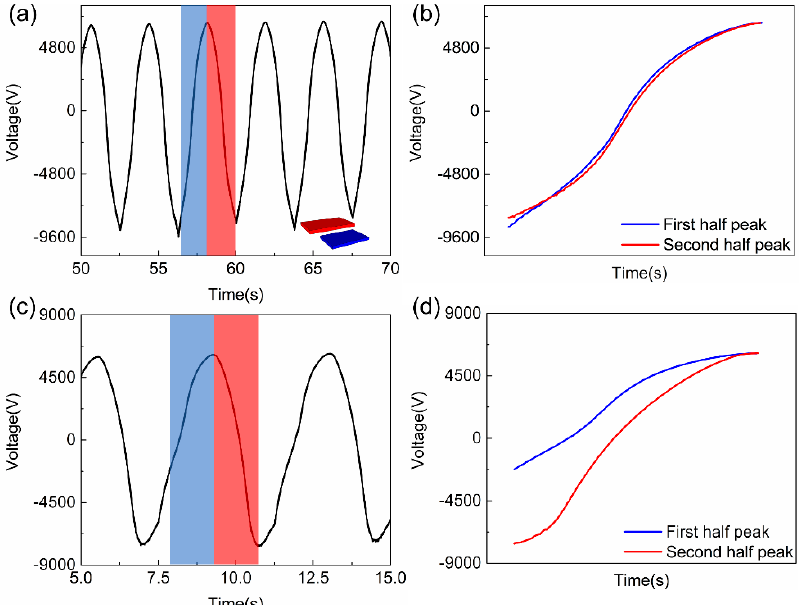
Figure 9. The voltage output of the rectangular patterned TENG under external load of ( a ) 10 12 and ( c ) 10 11 Ω . The voltage output of one cycle under external load of ( b ) 10 12 and ( d ) 10 11 Ω , demonstrating the voltage change of rectangular patterned TENG under lower external load and can be used in sensing applications to decide whether the moving tribo-material is under approaching or leaving state.